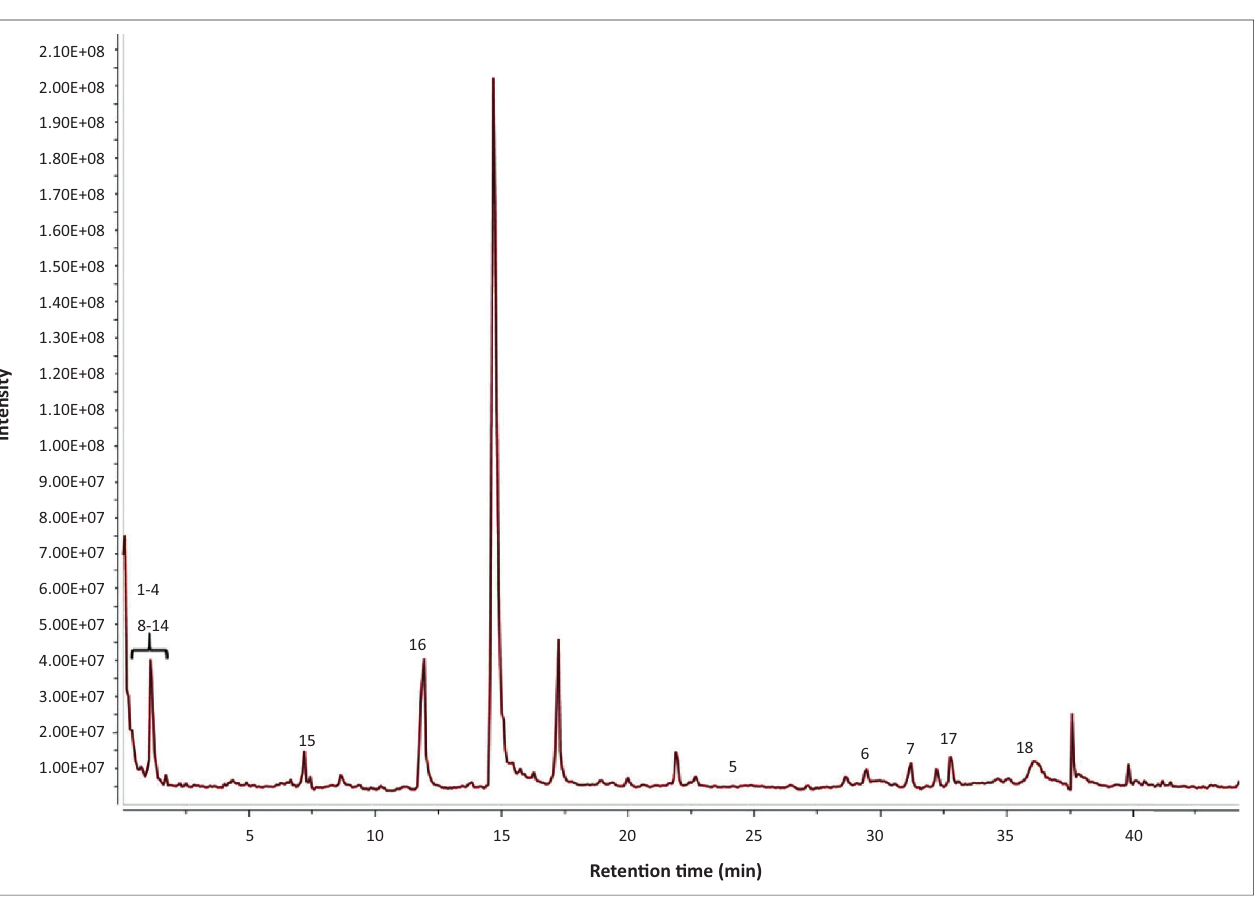
FIGURE 8: Total ion chromatogram for Alchornea laxiflora showing identified metabolites (1–7) and unidentified but detected metabolites (8–18). The identification, molecular formula, molecular weight, mass-to-charge ratio ( m / z ) and retention time (RT) in minutes are indicated in Tables 1 and 2.